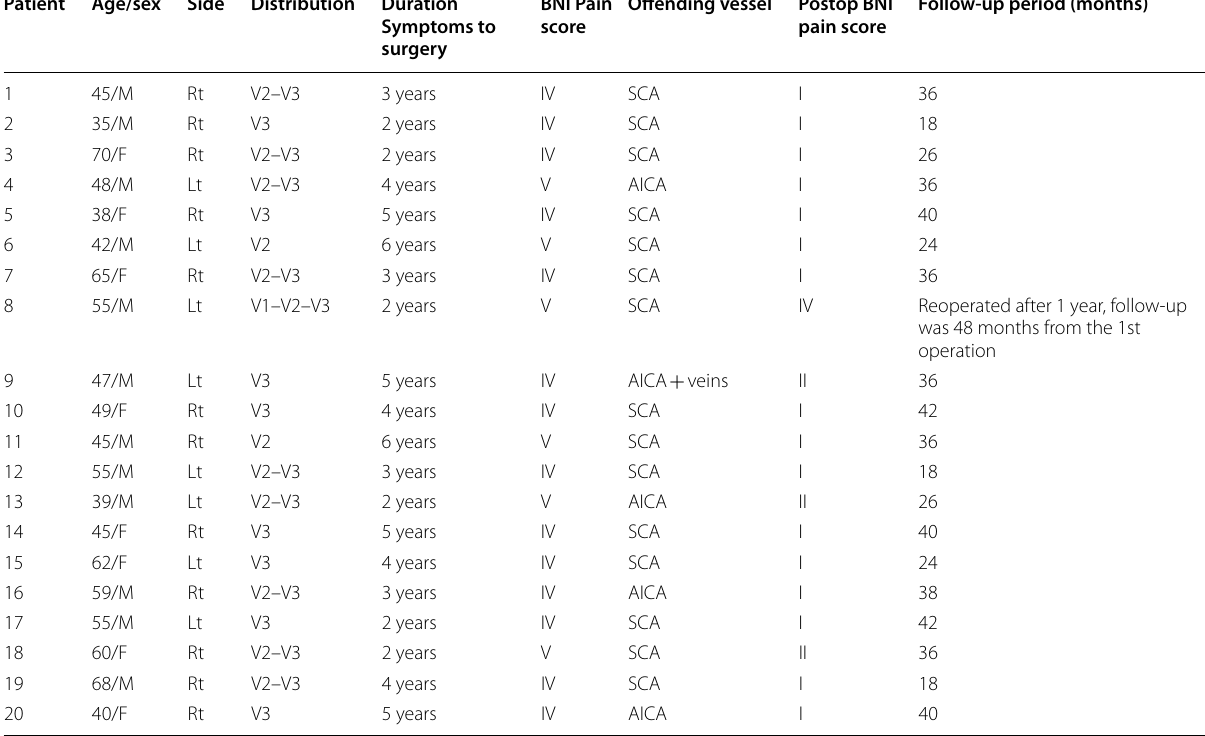
SCA Superior cerebellar artery, AICA Anterior–inferior cerebellar artery, BNI Barrow Neurological Institute